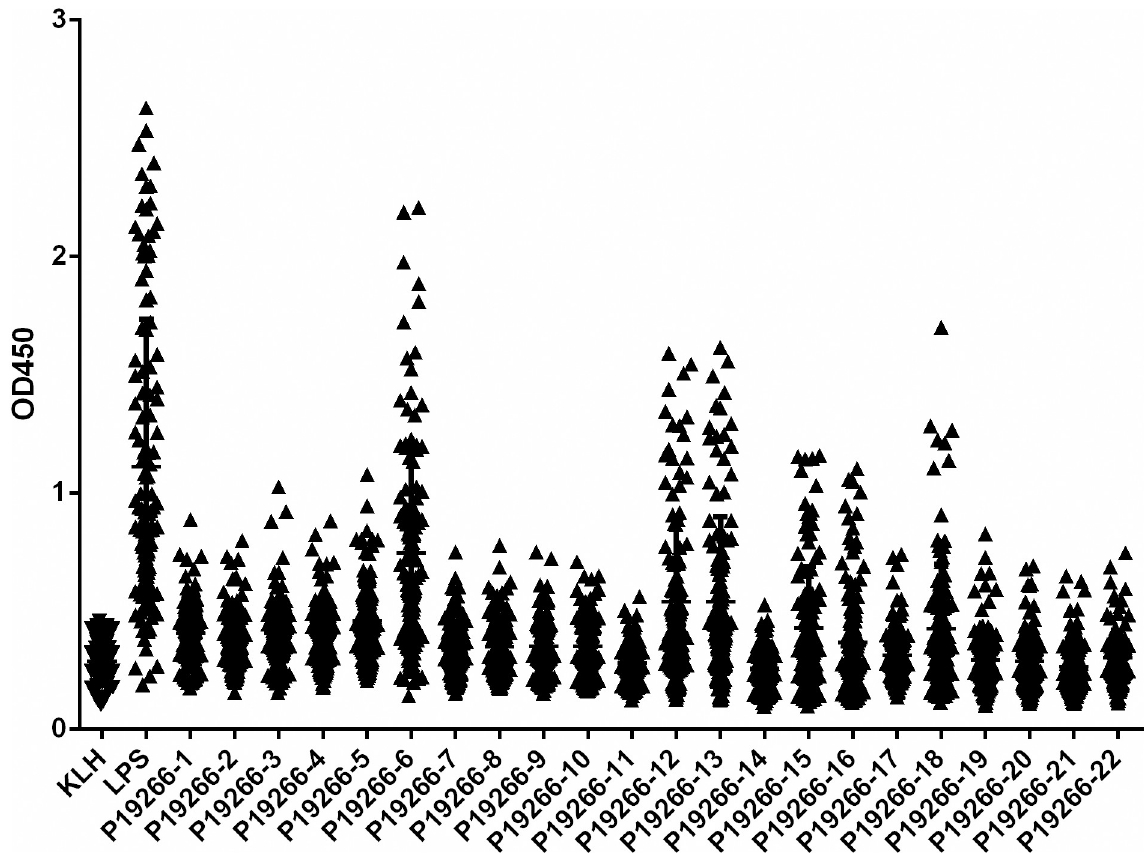
Fig 1. Dotplot result of 22 epitopes in identifying 121 human brucellosis positive serum by iELISA.